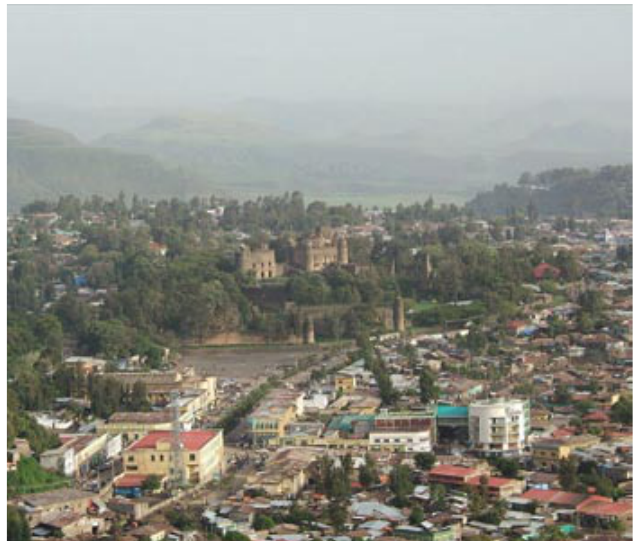
Figure 2 The city of Gondar.